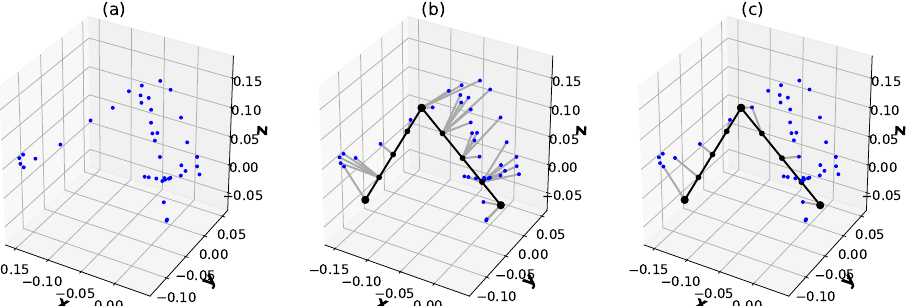
Figure 6. The quality measure for the graph fitting procedure. Robot arm pose (black), graph nodes (black dots), reference point cloud (( a ), blue dots), extended graph points C ext (smaller black dots). The closeness of the robot pose to the point cloud is the sum of minimal distances between graph nodes to the point cloud (gray lines, ( b )) and minimal distances between the point cloud to the graph nodes (blue lines, ( c )).